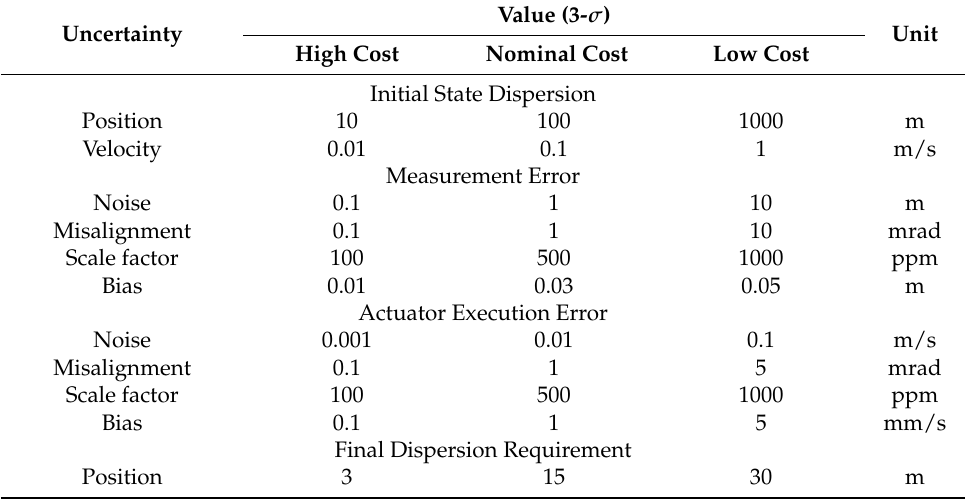
Table 2. Different levels of uncertainties (3- σ ) for high-, nominal- and low-cost systems.